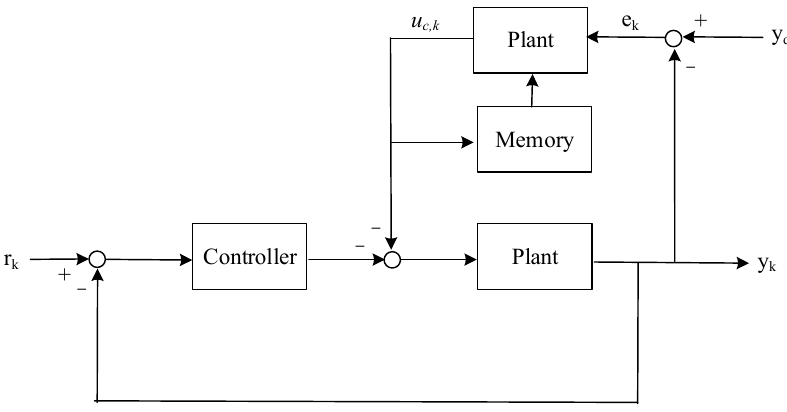
Figure 2. Block diagram of the input-based ILC.